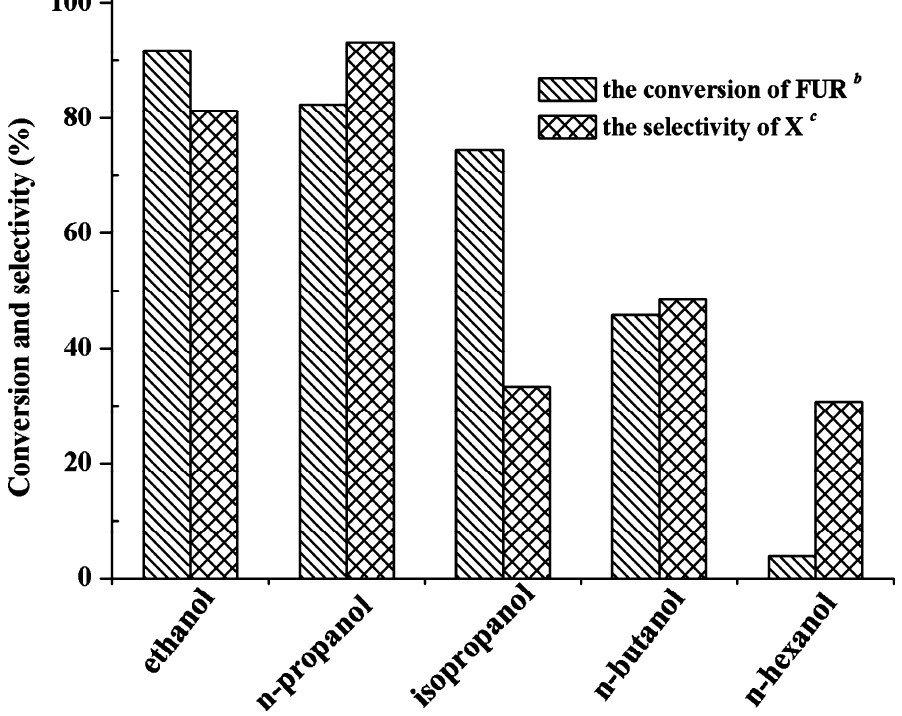
Figure 6. Oxidative condensation of furfural with various alcohols. Reaction conditions: 0.2 g of furfural, 0.05 g Co x O y -N/K-10 catalyst (2 wt% loading) and 0.05 g Cs 2 CO 3 , 15 mL n-propanol, 0.3 MPa O 2 , 140 °C, 4 h. b The conversion of furfural. c The selectivity of oxidative condensation products. Reproduced with permission from [26]. Copyright: American Chemical Society 2016.